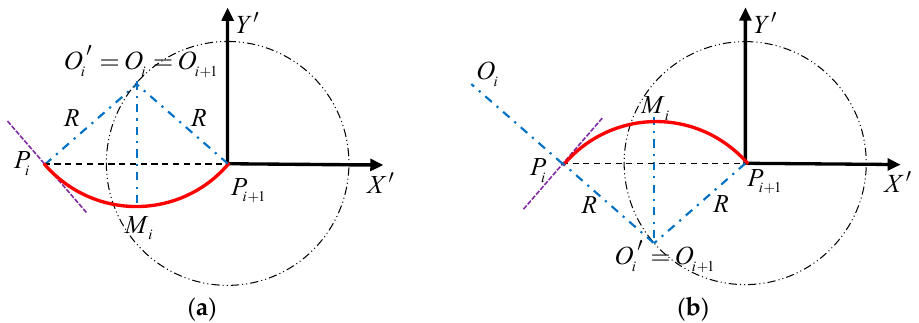
Figure 5. Schematic diagram of route planning when the distance D O turning radius R . ( a ) is the schematic diagram of route planning at ∠ O i P i P i + 1 ≤ 90, ( b ) is the schematic diagram of a route planning at ∠ O i P i P i + 1 > 90, the red line is the calculated shortest